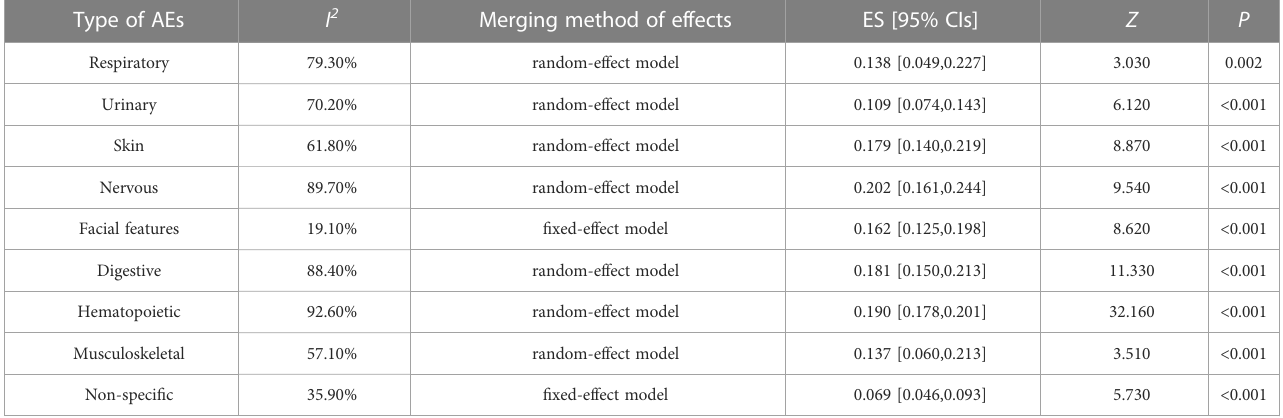
TABLE 4 The incidence of AEs in the overall estimate with whole body system.